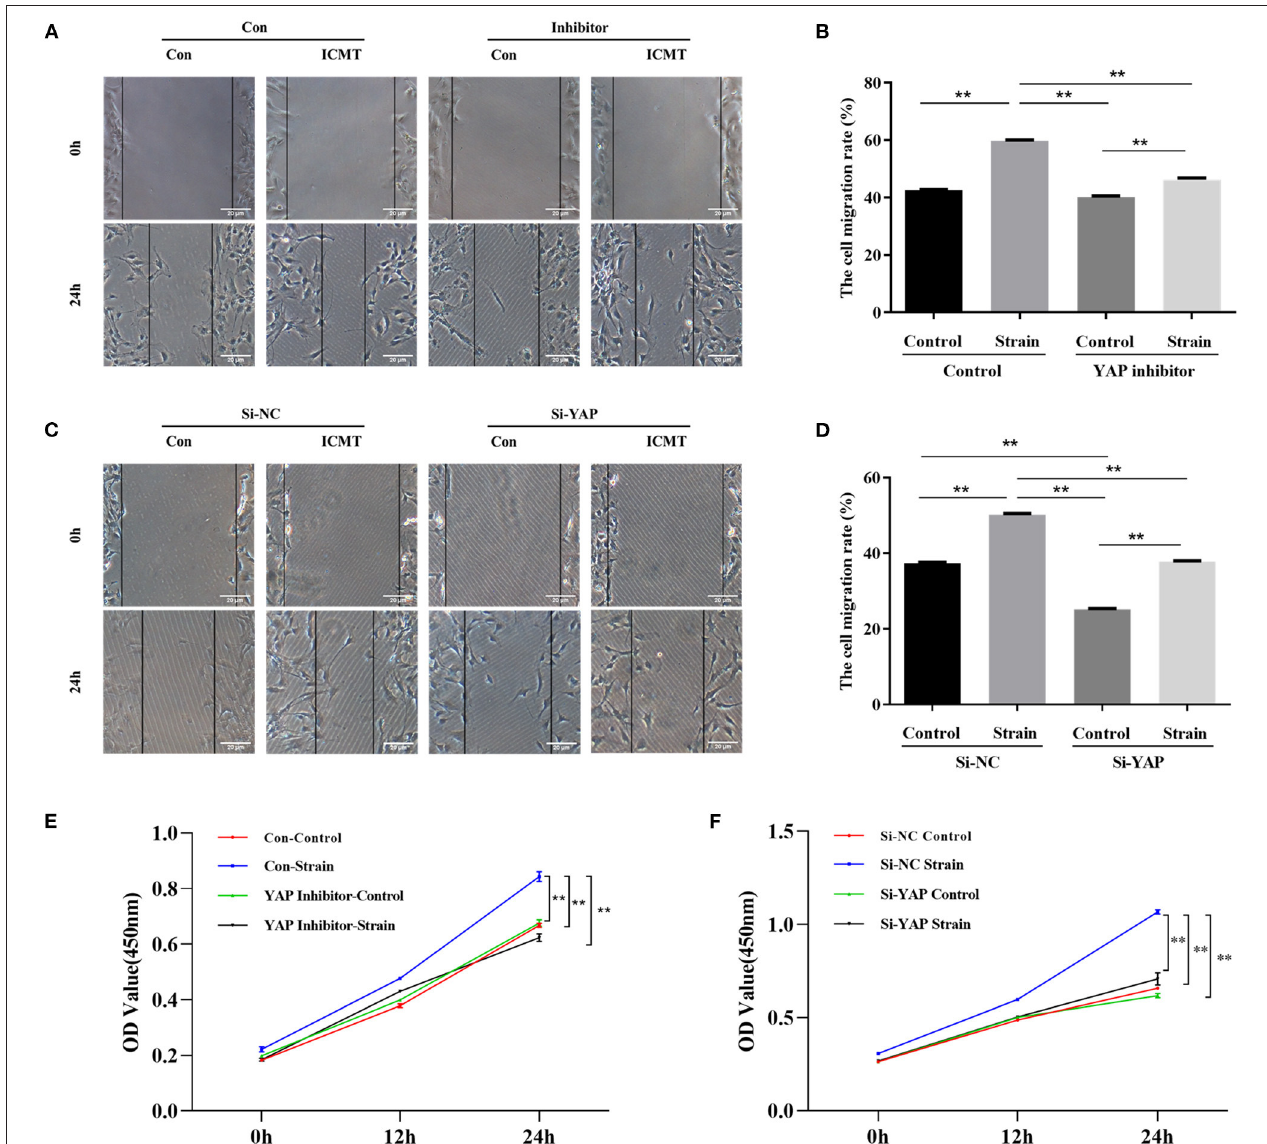
FIGURE 4 | Mechanical strain induces HSFs motility and proliferation by activating YAP. (A) HSFs motility was detected by the scratch assay in the context of YAP inhibition. (B) Quantitative analysis of cell migration. (C) HSFs motility was detected by the scratch assay in the context of YAP knockdown. (D) Quantitative analysis of cell migration. (E) HSFs proliferative capacity was determined by CCK-8 assay in the context of YAP inhibition. (F) HSFs proliferative capacity was determined by CCK-8 assay in the context of YAP knockdown. HSFs of the strain group were subjected to 10% cyclic strain at 0.5Hz for 8h. ** P < 0.001. Con, control; ICMT, intermittent cyclic mechanical